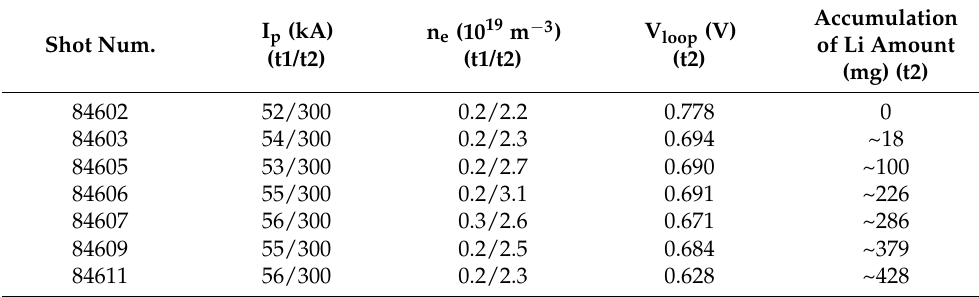
Table 2. Plasma parameters of I p ramp-up phase (t1 = 0.08 s) and I p platform phase (t2 = 5.0 s) during lithium granule